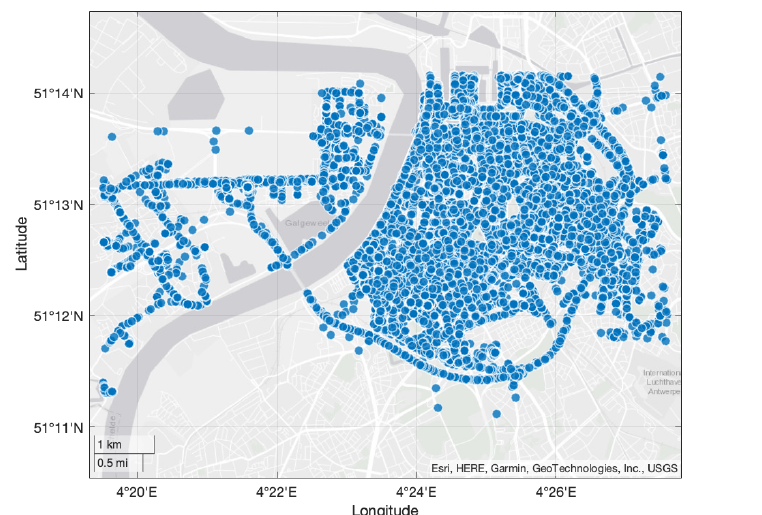
Figure 2. LoRaWAN dataset collected in Antwerp city